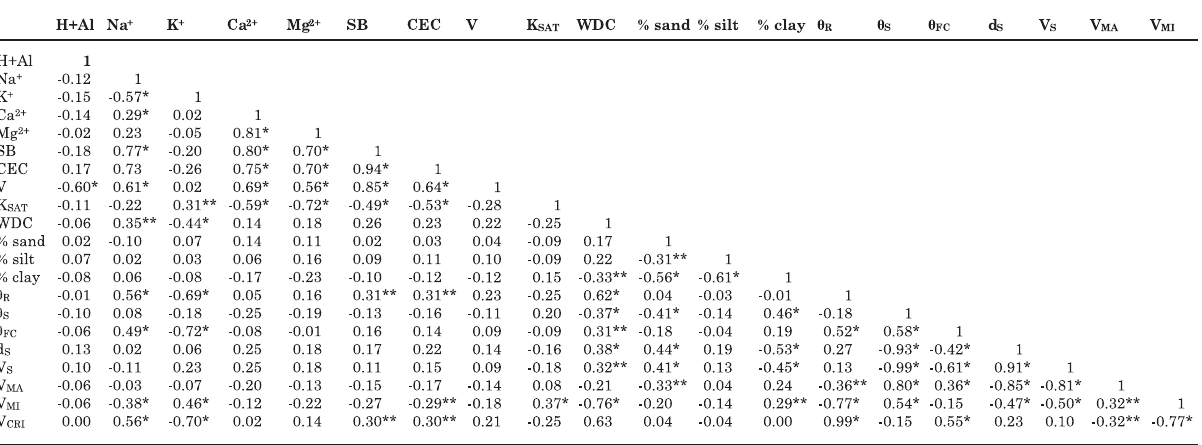
Table 4. Pearson correlation coefficients among physical and chemical soil